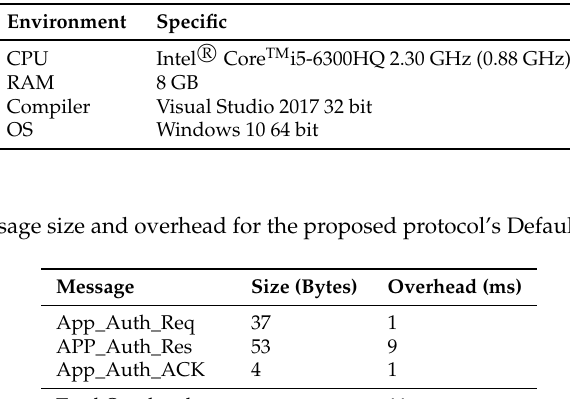
Table 9. Proposed protocol environment for evaluation.